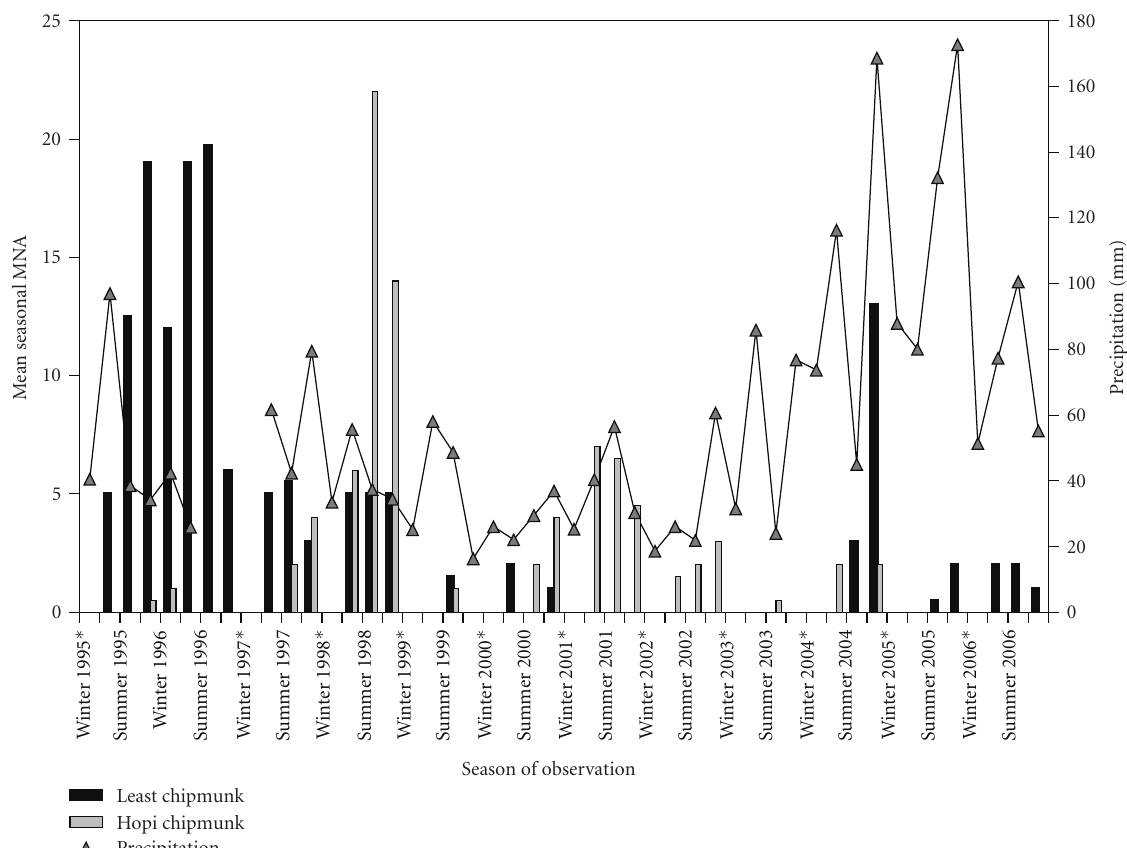
Figure 1: Mean minimum number of chipmunks alive (MNA) and precipitation at Molina, Colorado by season. ∗ Indicates winters when trapping was not